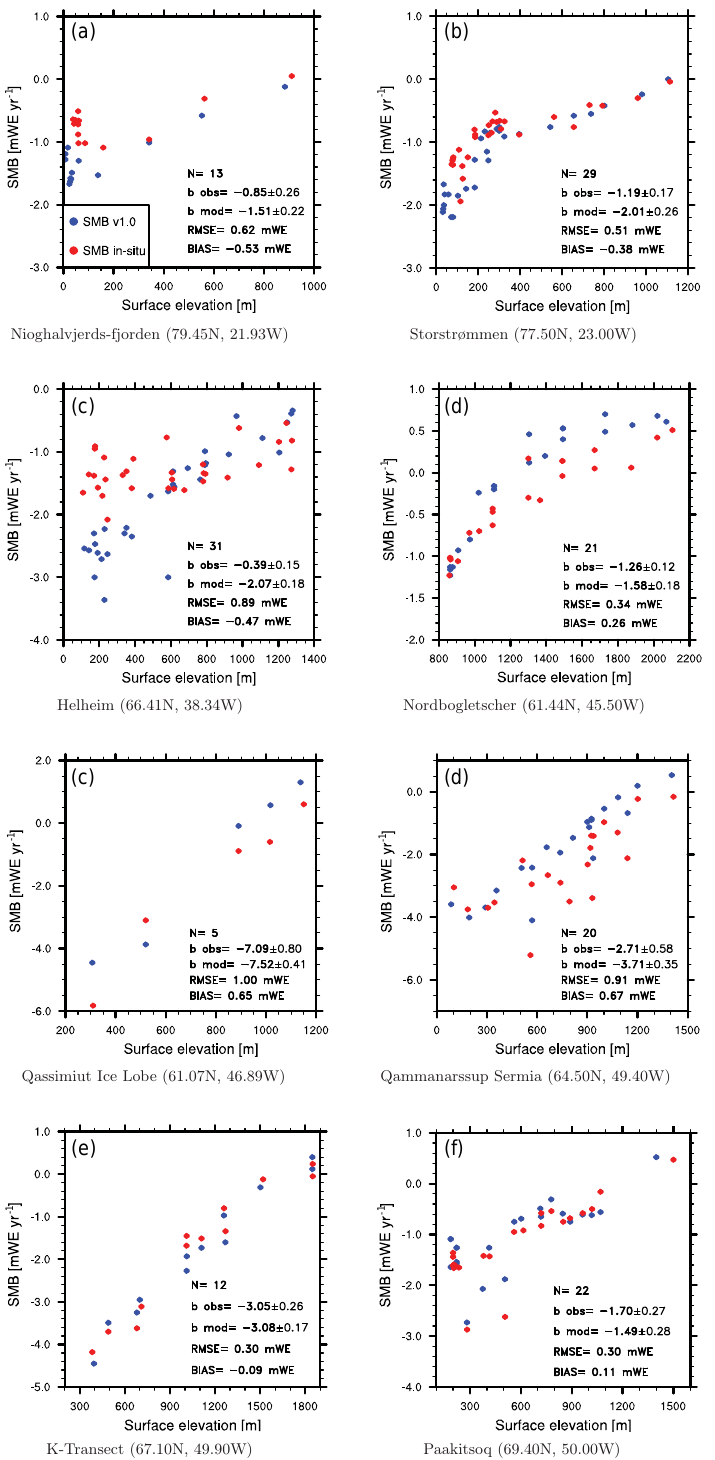
Figure 9. Annual mean observed (red dots) and downscaled (blue dots, v1.0) SMB for eight selected transects in the GrIS ablation zone (mWEyr − 1 ). Name and locations of these transects (Fig. 1) are listed at the bottom of each graph. Graphs also list the number of sites used for each transect, linear SMB-to-elevation regression retrieved from observations and downscaled (v1.0) data in mmWEyr − 1 m − 1 , the RMSE and the mean